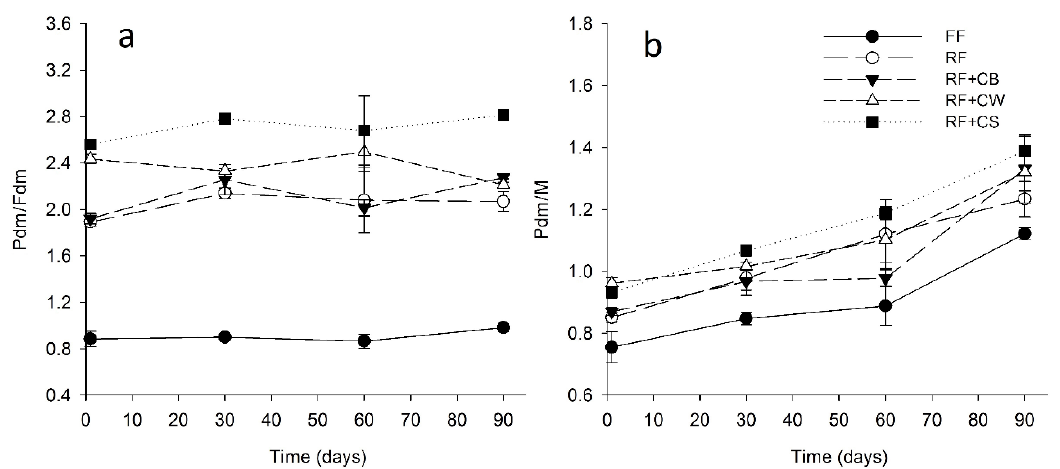
Figure 3. Ratio protein in dry matter/fat in dry matter (Pdm/Fdm) ( a ) and protein in dry matter/moisture (Pdm/M) ( b ) of tested cheeses over ripening. (FF): full-fat; (RF): reduced-fat; (RF + CB): reduced-fat with concentrated buttermilk; (RF + CW): reduced-fat with concentrated whey; (RF + CS): reduced-fat with concentrated second cheese whey.